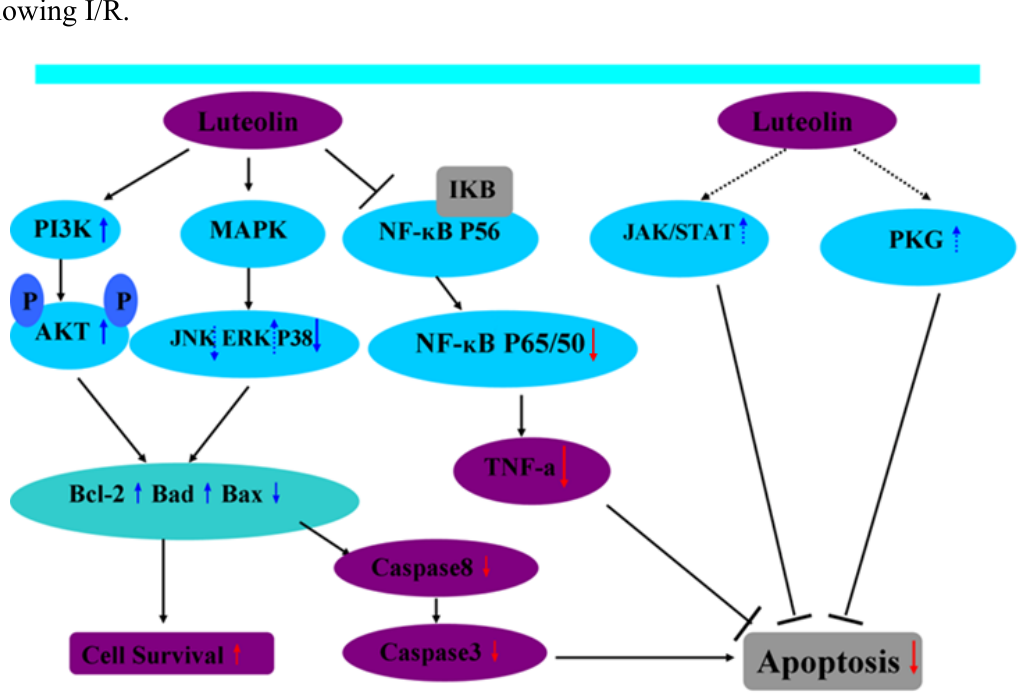
Figure 2. Possible mechanisms for luteolin exerting its protective effects on cardiomyocytes following